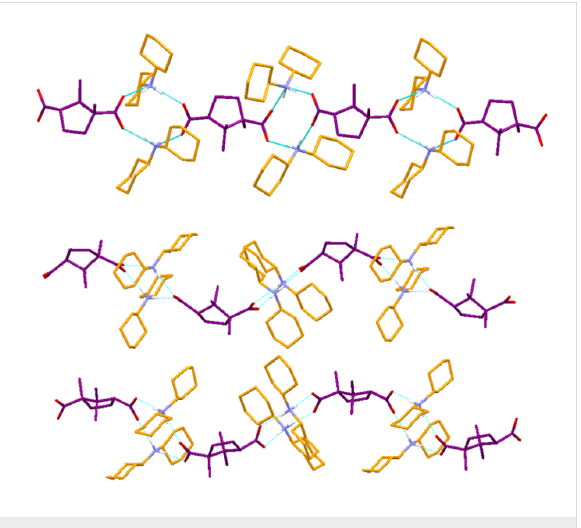
Figure 7: Illustration of crystal structure of DCHADC 1 ; top – 1-D hydrogen bonded zigzag chain displaying SAD synthon; bottom – packing of such zigzag